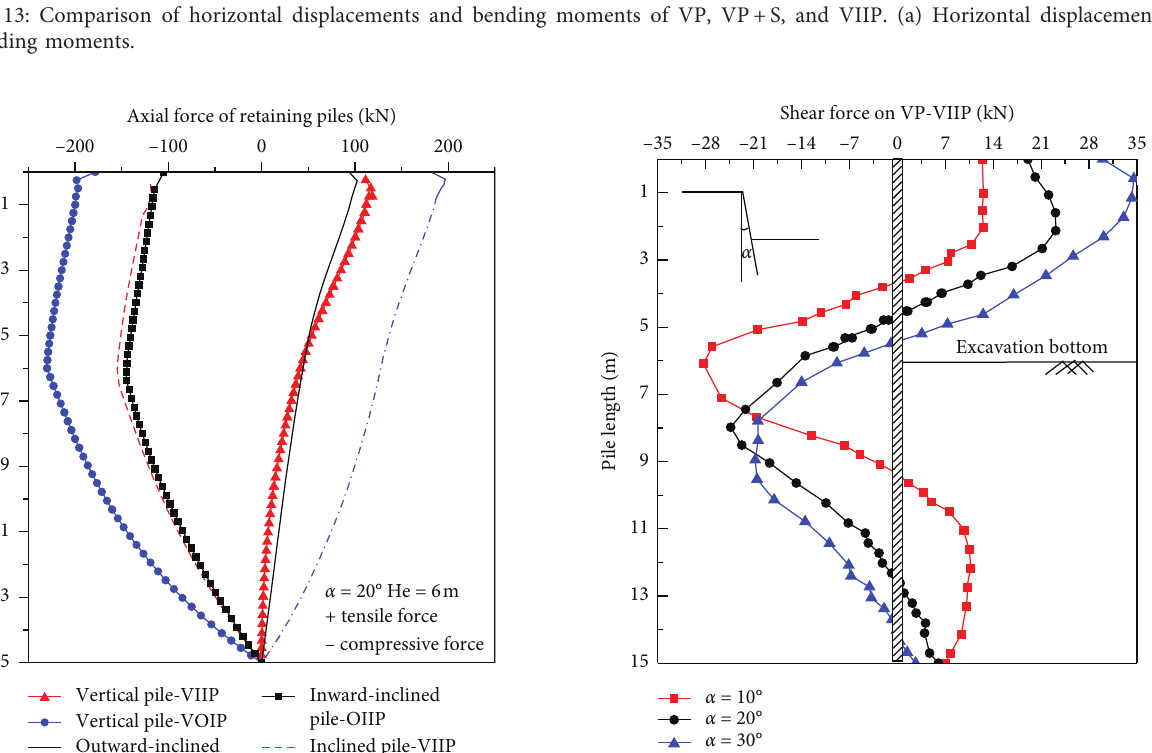
Figure 15: Shear forces acting on the